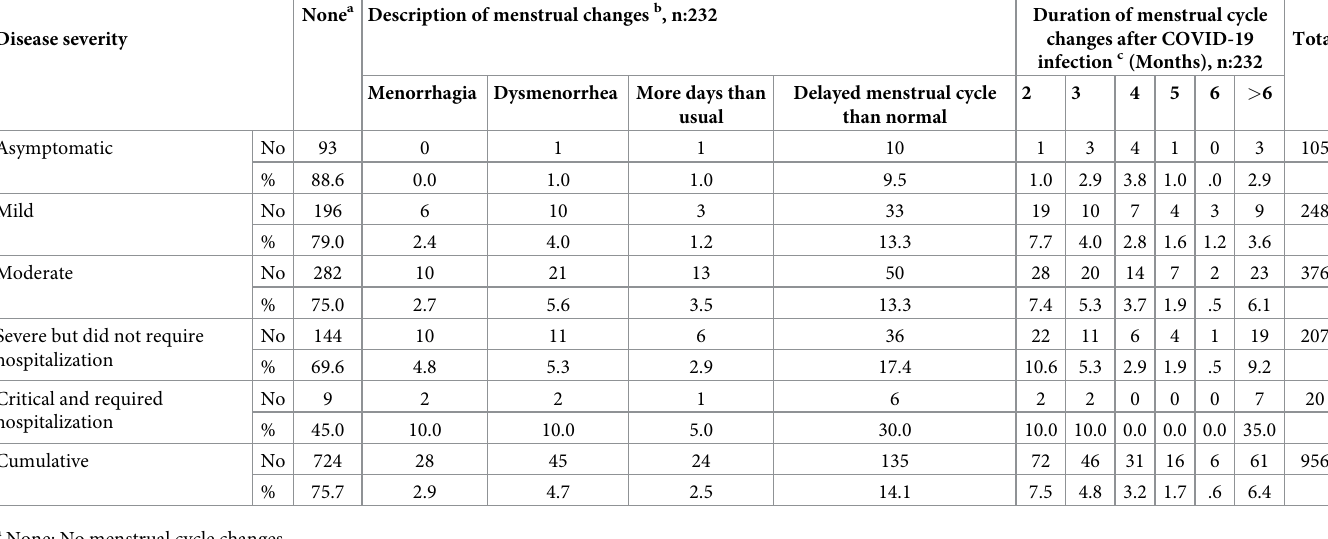
Table 4. Effect of COVID-19 severity on the development of menstrual cycle changes following SARS-CoV-2 infection. None a Description of menstrual changes b , Disease severity